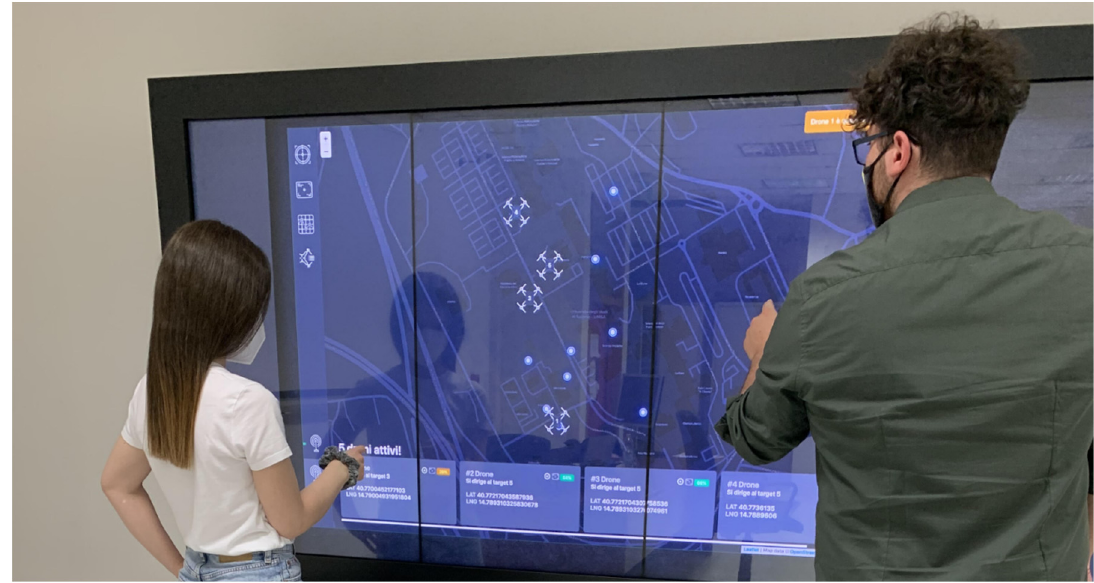
Figure 5. Two users operating in the “Shared” setting during the experiment.